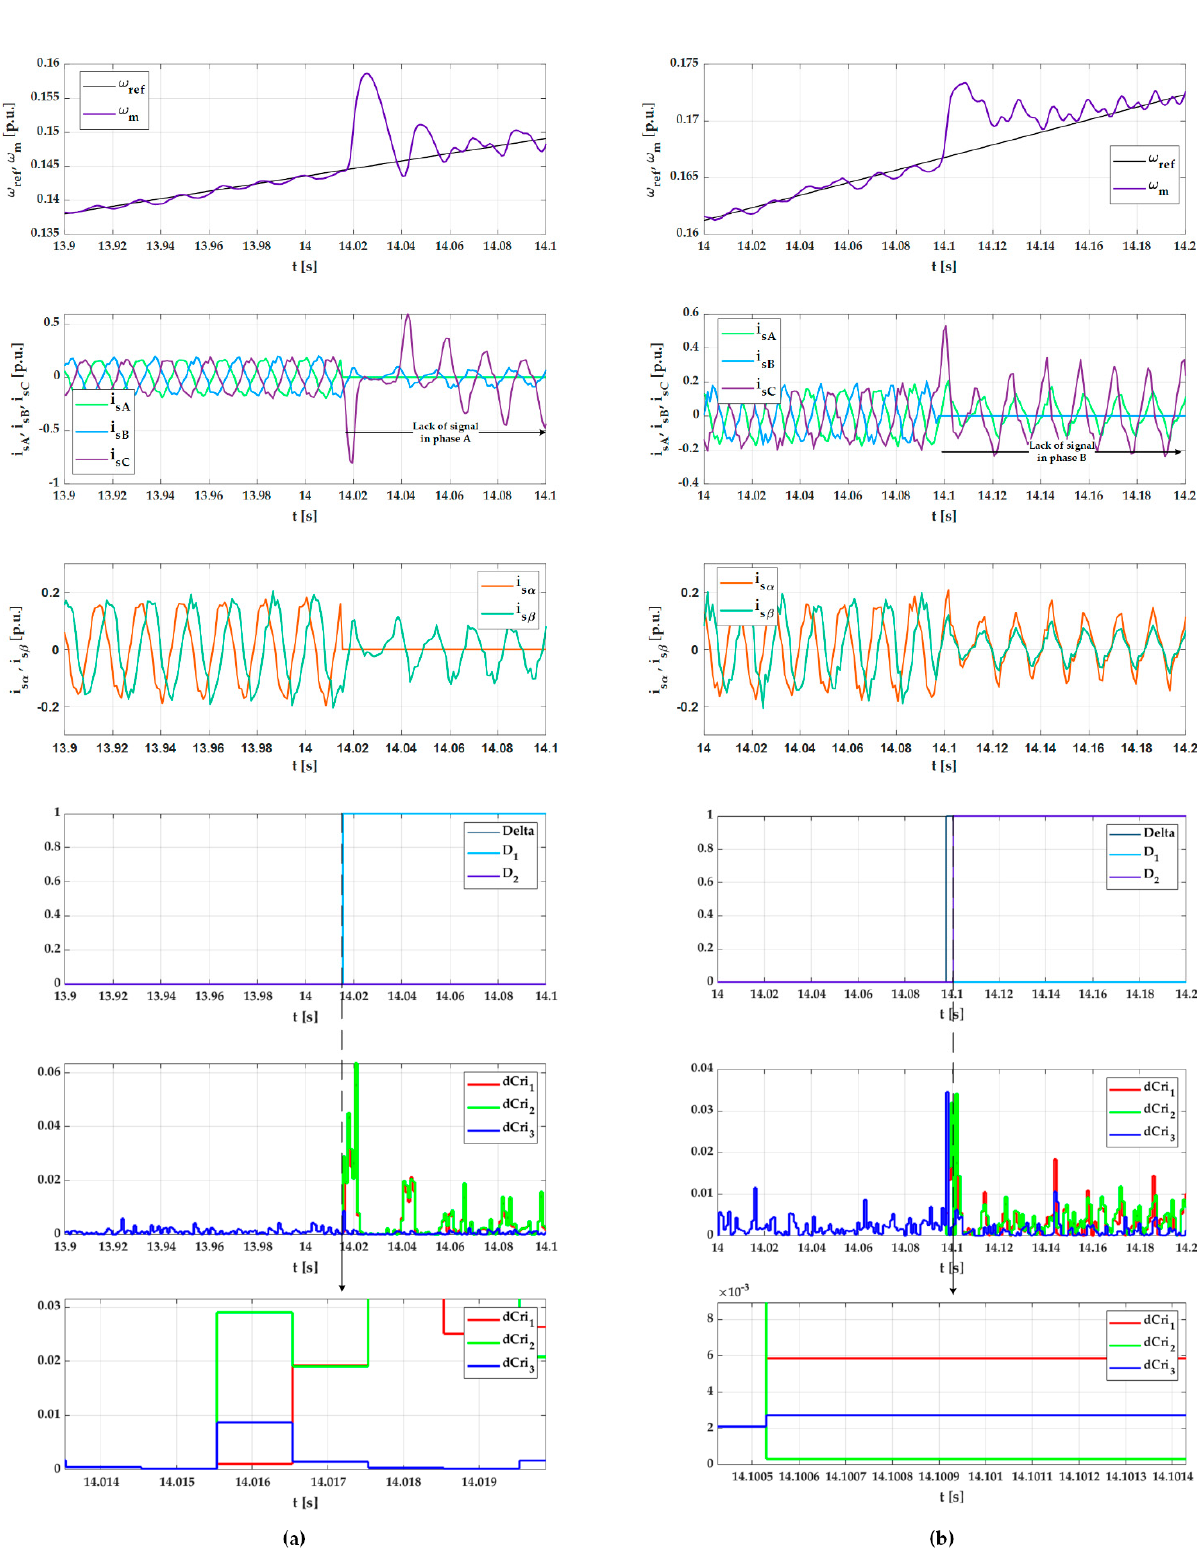
Figure 12. Transients of speed, stator currents, stator current components, detector response, and marker errors during signal interruptions without motor load in phase A ( a ) and B ( b ).